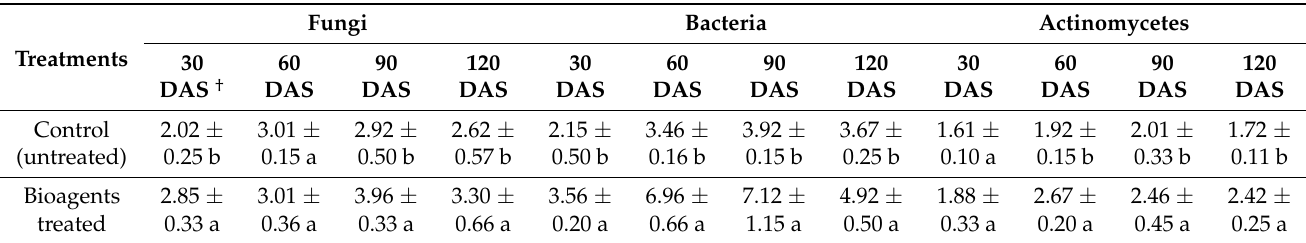
Table 3. Effect of bioagent treatment and agronomic practices of log CFU count of bacteria, fungi and actinomycetes in wheat rhizosphere under salt stress conditions.